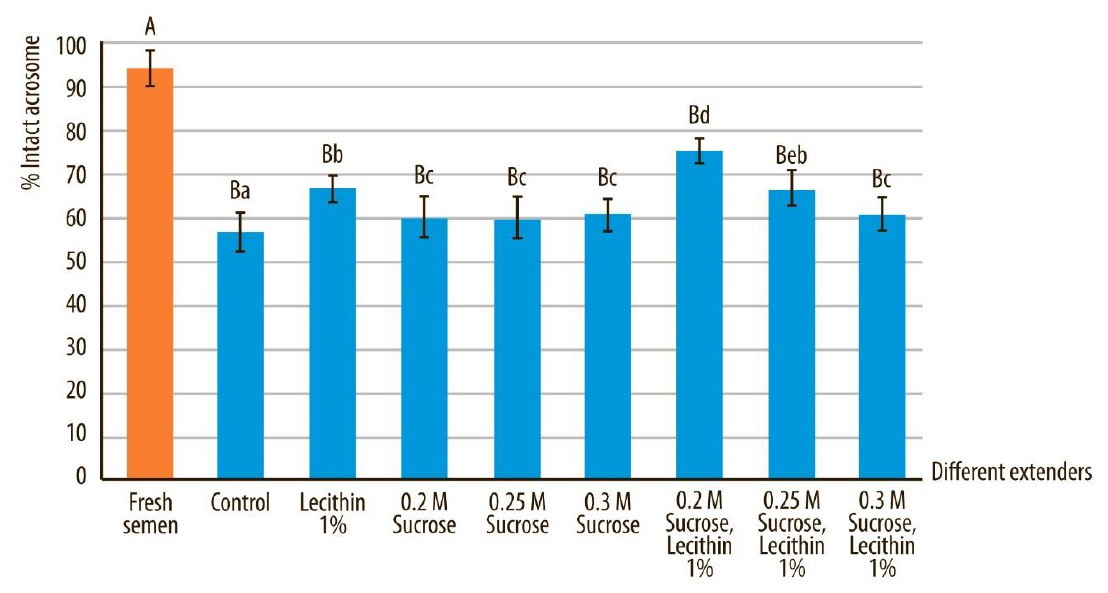
Figure 6. Intact acrosome based on Spermac staining in canine sperm after devitrification regarding di ff erent vitrification media. Data are expressed as mean ± SD.